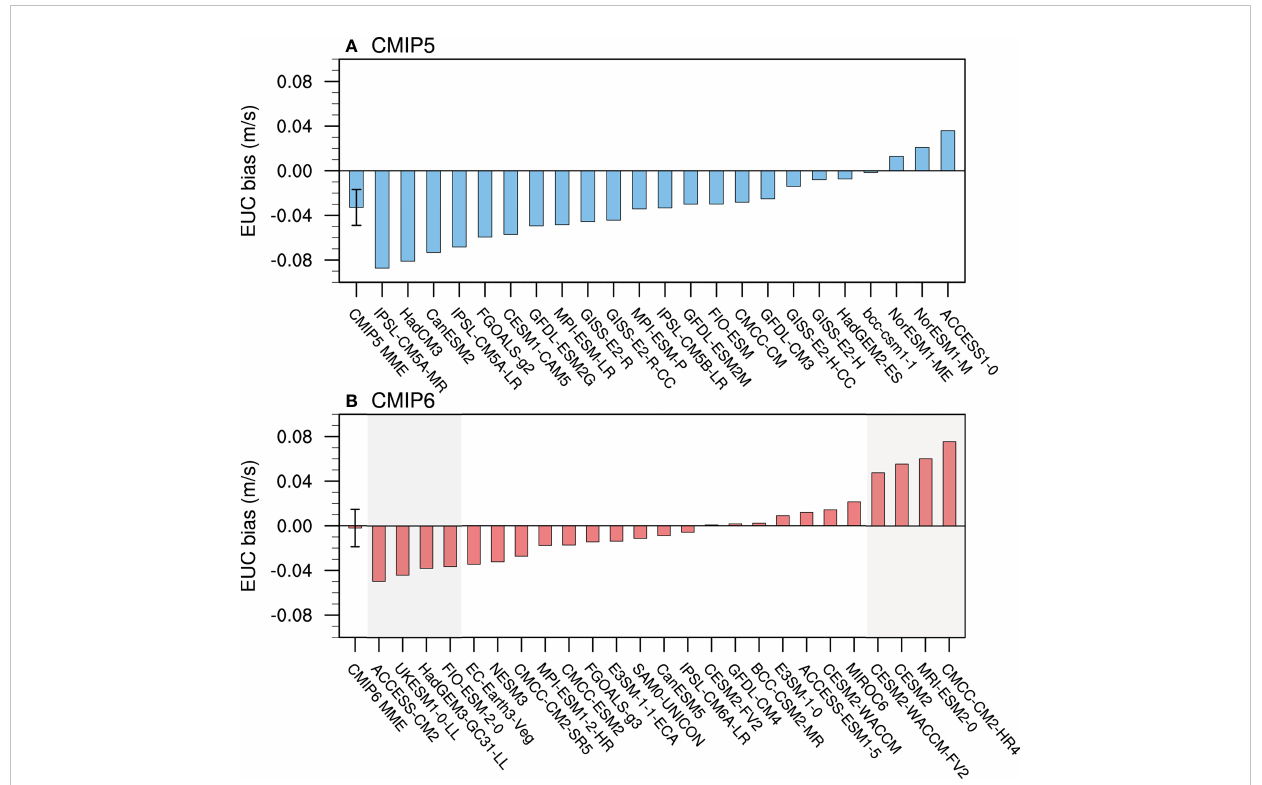
FIGURE 7 JFM mean EUC biases (units: m/s) averaged over the region (2° S – 2° N, 50 – 95° E) among the (A) CMIP5 and (B) CMIP6 models. The fi rst bar and its corresponding error bar indicate the MME bias and the standard deviation spread among the CMIP5 and CMIP6 models, respectively. The gray shading on the left and right of (B) indicate the four weak EUC models (WEUC group) and the four strong EUC models (SEUC group),